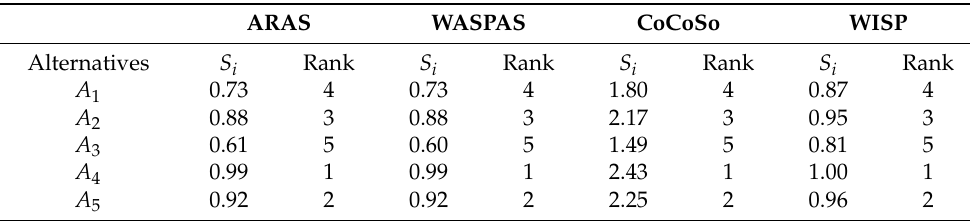
Table 9. Ranking of alternatives using ordinary ARAS, WASPAS, CoCoSo and WISP methods. ARAS WASPAS CoCoSo WISP